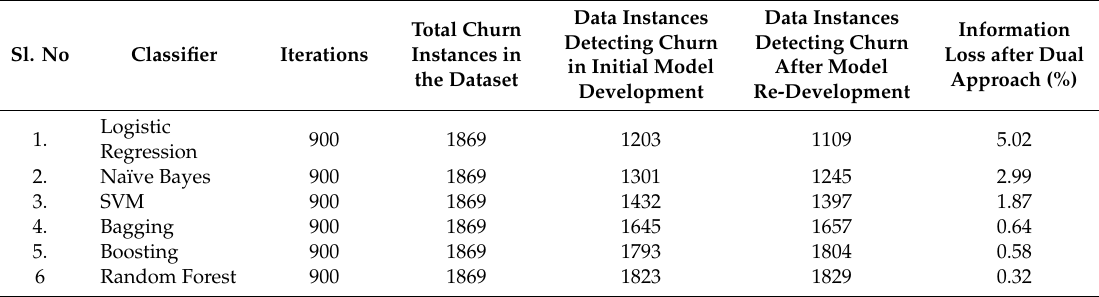
Table 8. Information loss analysis in two phases of model